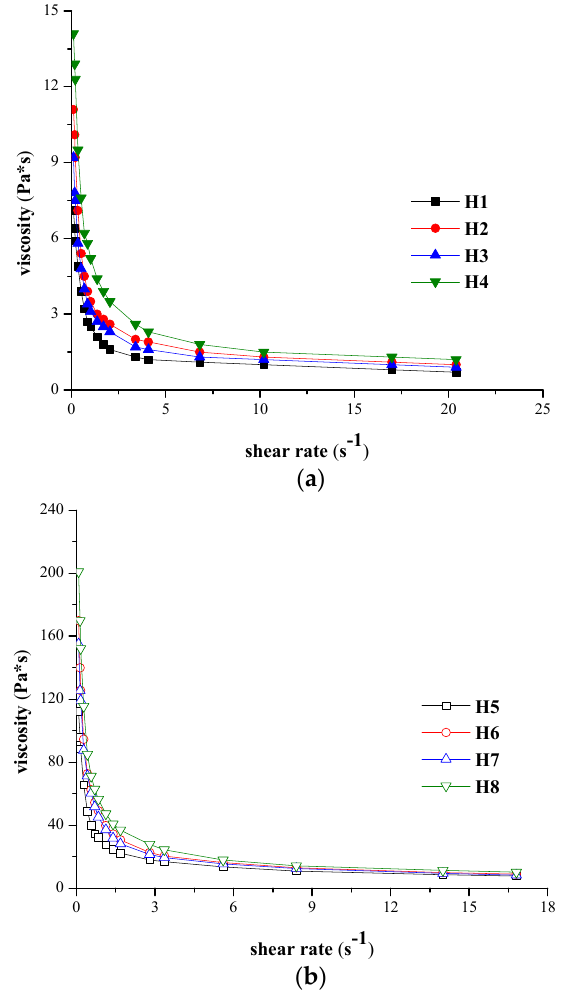
Figure 3. Viscosity vs. shear rate for: ( a ) hydrogels with minimum concentration of NaCMC analyzed at 37 °C; ( b ) hydrogels with maximum concentration of NaCMC analyzed at 23 °C.